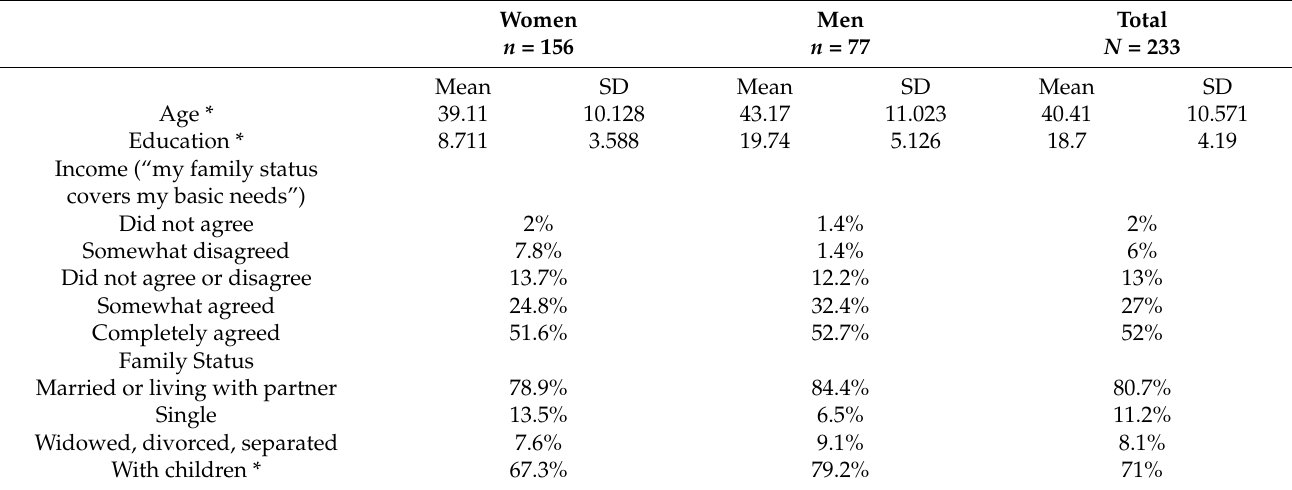
Table 1. Demographic characteristics of the